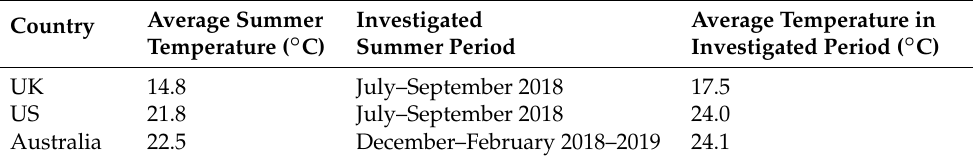
Table 1. Summary of researched summer conditions compared to previous conditions